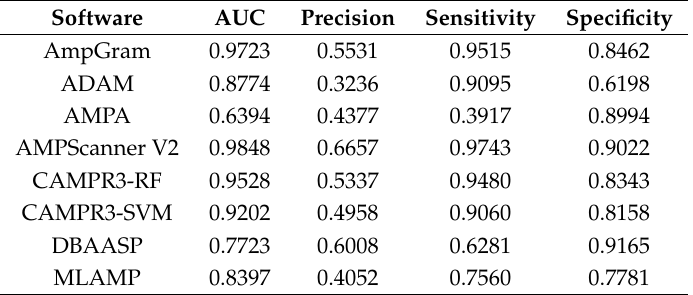
Table 4. Comparison of AmpGram and AMPscanner [24] performance on the APD dataset with other predictors from Gabere and Noble’s benchmark and according to their methodology [29]. The very low values of precision are due to the very large negative dataset used (for details, see Section 3).